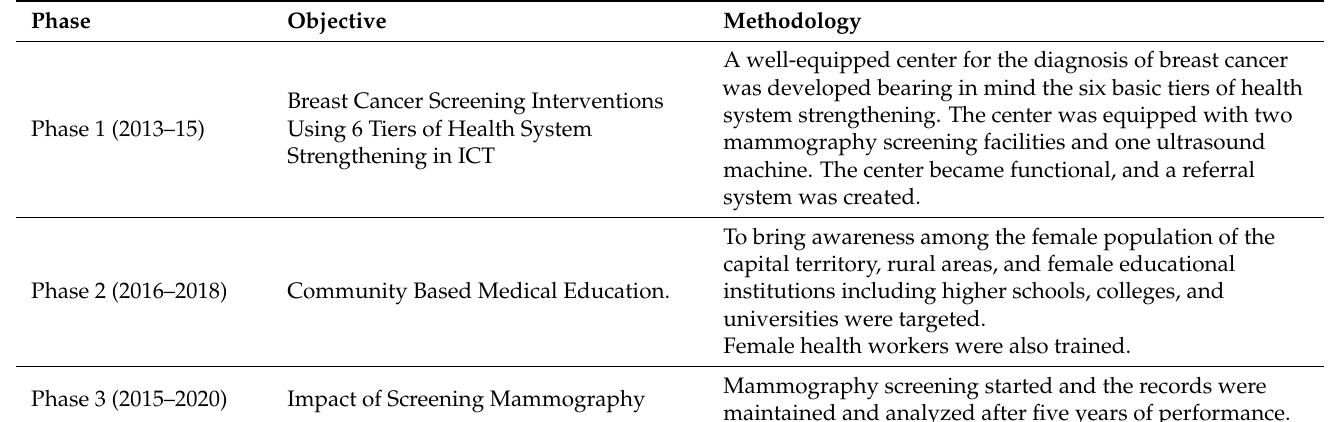
Table 1. The study design depicting the phase wise